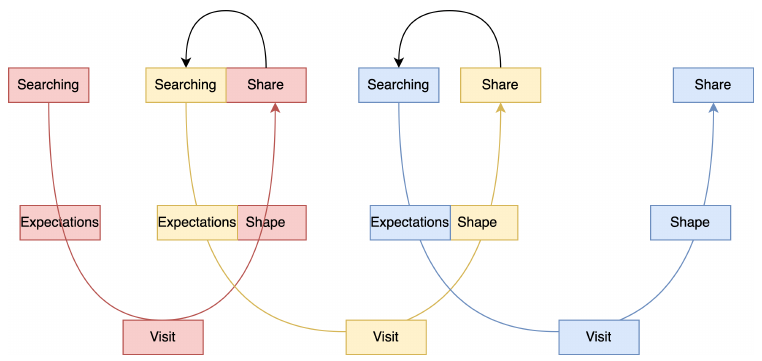
Figure 1. Virtuous